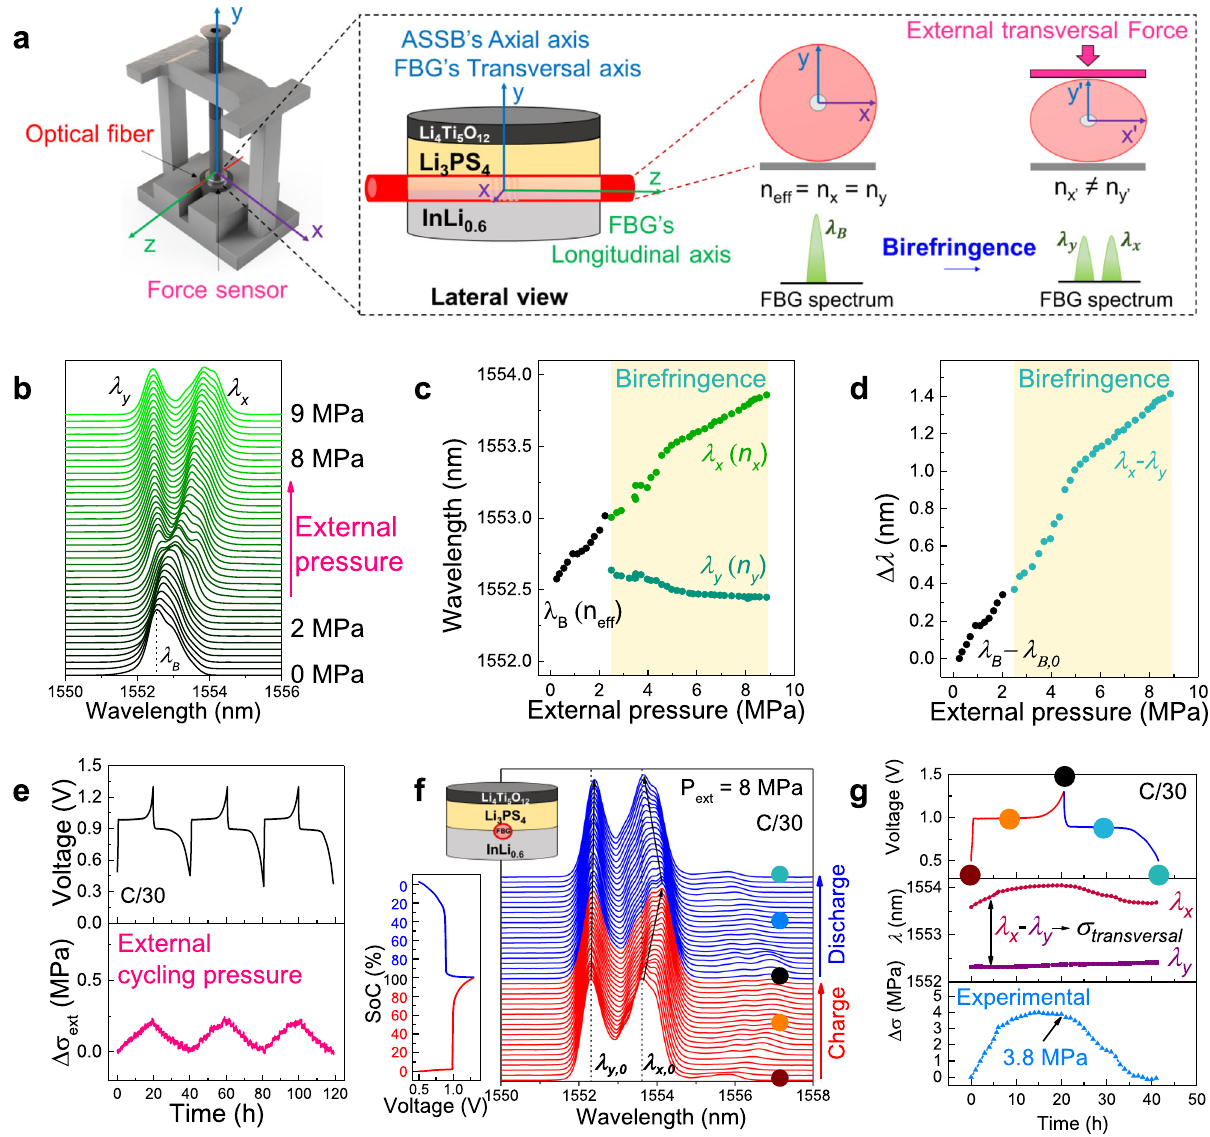
Fig. 5 Operando Li-driven stress monitoring in InLi x | LPS | LTO cell by an FBG placed at the interface between the anode and the solid-state electrolyte. a Scheme of the modi fi ed coin cell with the implemented optical fi ber and the external force sensor. The corresponding X -, Y -, and Z -axis are detailed in the different views. For the sake of simplicity, the “ longitudinal ” and “ transversal ” axis is used with respect to the optical fi ber, and the “ axial ” axis is only used with respect to the cell. The scheme of the birefringence phenomena is presented. b – d Experimental calibration curve of the FBG sensor when the ASSB is in an OCV status. The externally applied pressure is increased externally from 0 to 9 MPa. Detailed values of λ B , λ x , and λ y vs. the externally applied pressure with the force sensor. The birefringence regime is shadowed in light yellow. Two regions are observed: 1 — when only one peak is observed in the spectra ( λ B , given by λ B = 2 n eff Λ ), the calibration is done by λ B – λ B ,0 and 2 — the birefringence regime when λ x and λ y can be followed. The difference between λ x and λ y is used in order to calibrate internal transverse stresses. In our case, we focused on externally applied pressure of 8 MPa to pro fi t from the birefringence phenomenon. Thus, the slope of the linear fi tting in the upper birefringence regime (5 – 9 MPa) is 0.105 nm MPa − 1 . e Time- resolved voltage (top), and external cycling pressure (bottom) for the aforementioned ASSB cycled at C/30 (5.83 mA g − 1 ) and 25 °C in an operando mode. f 2D stack view of the operando collected spectra by the FBG sensor, with the corresponding galvanostatic charge/discharge cycle. The charge and discharge processes are plotted in red and blue, respectively. g Galvanostatic cycle (top), λ x and λ y evolution (middle) and o perando stress evolution obtained internally by the FBG sensor and with the experimental calibration of the sensor (bottom). The points at the beginning/middle/end of the charge/ discharge are indicated by colored dots, also marked in the corresponding FBG spectra in ( f